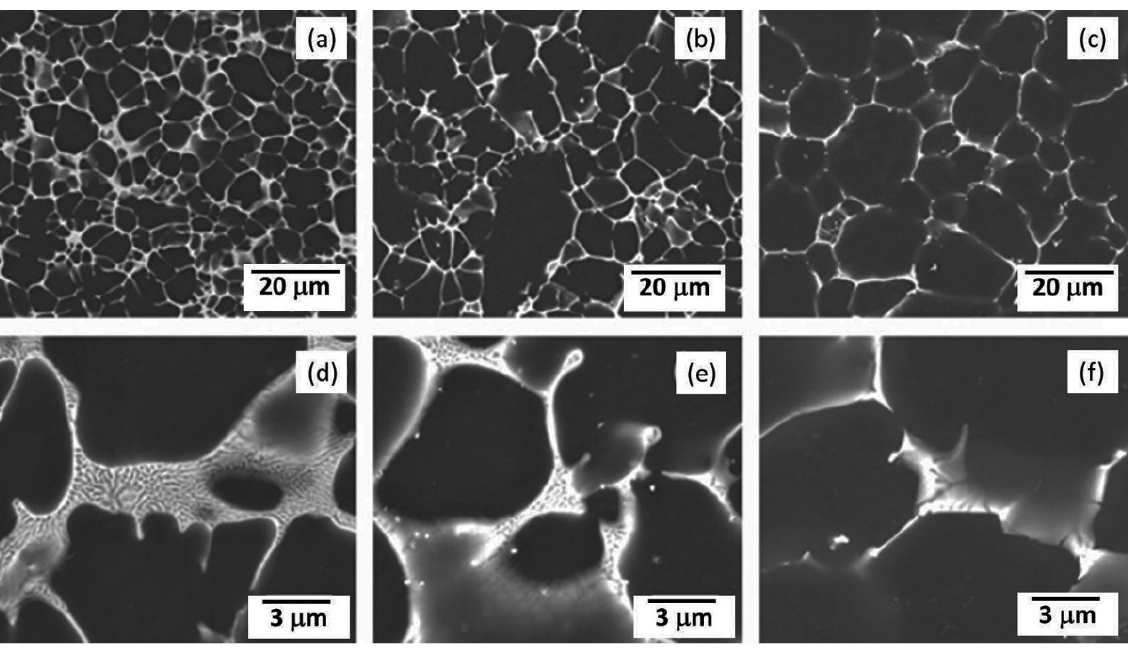
Figure 11. SEM images showing microstructures in the HPDC ( a , d ) Mg-3.44La; ( b , e ) Mg-2.87Ce; ( c , f ) Mg-2.60Nd alloys [147]. ( c , f ) Mg-2.60Nd alloys